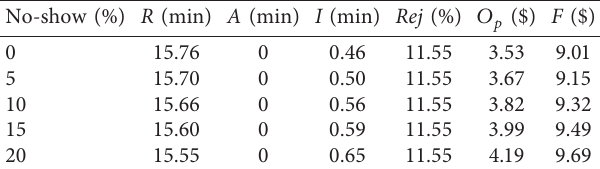
Table 3: Simulation results with different no-show rates.